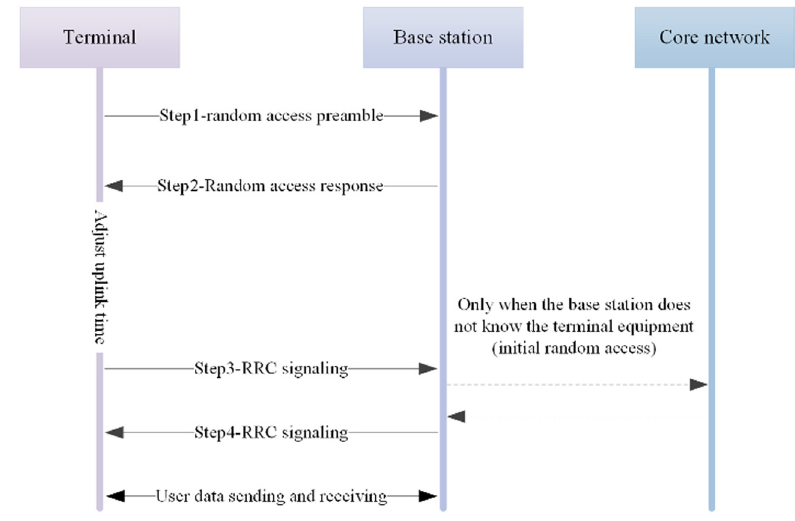
Figure 2: Random access process of mobile cellular